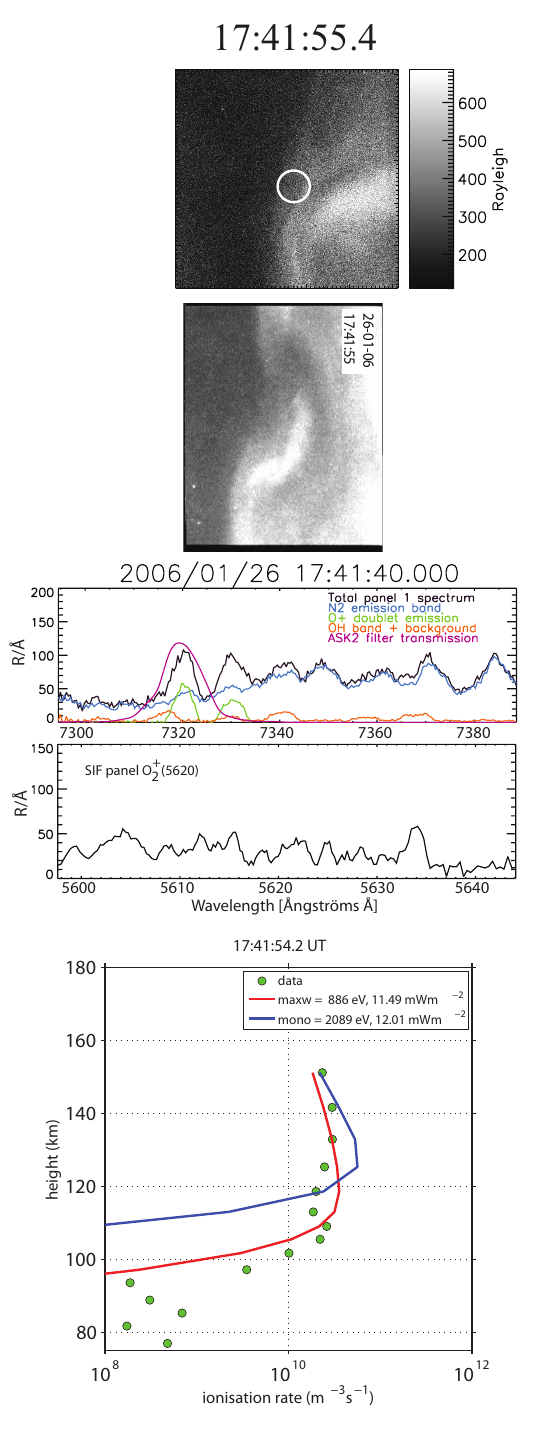
Fig. 6. Event 2: Optical and electron density data from 17:41:55UT. The top image is ASK3, the second is a SIF video camera image, the third and fourth rows the SIF spectra. The bottom row are ionisation rate profiles derived from the ESR electron den- sity profiles, and best fit model profiles with assumed Maxwellian and monoenergetic energy distributions.